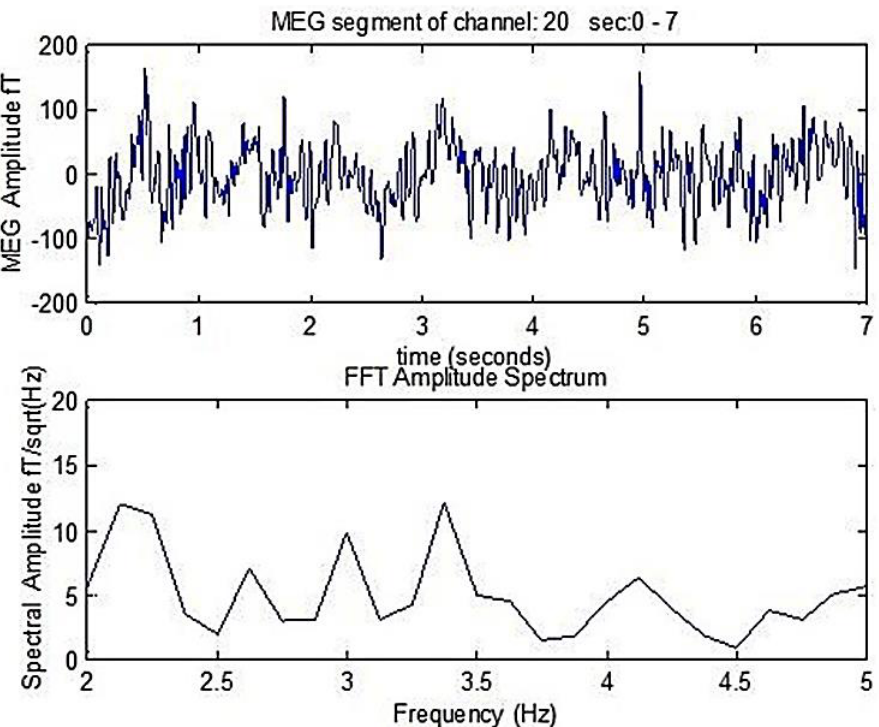
Figure 1. A 0 – 7s MEG segment of an AD patient (up) and the corresponding amplitude spectrum that is obtained after the application of FFT (bottom). The dominant frequency is 2.1